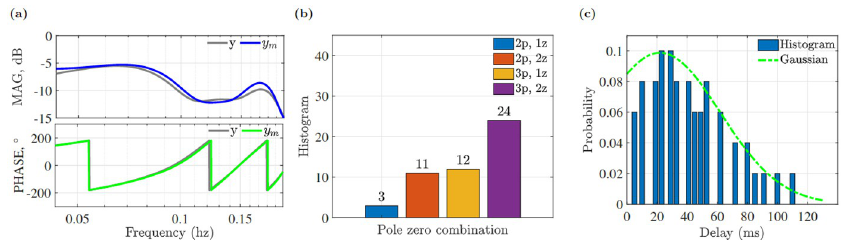
( s ), (b) histogram of pole zero combination, m